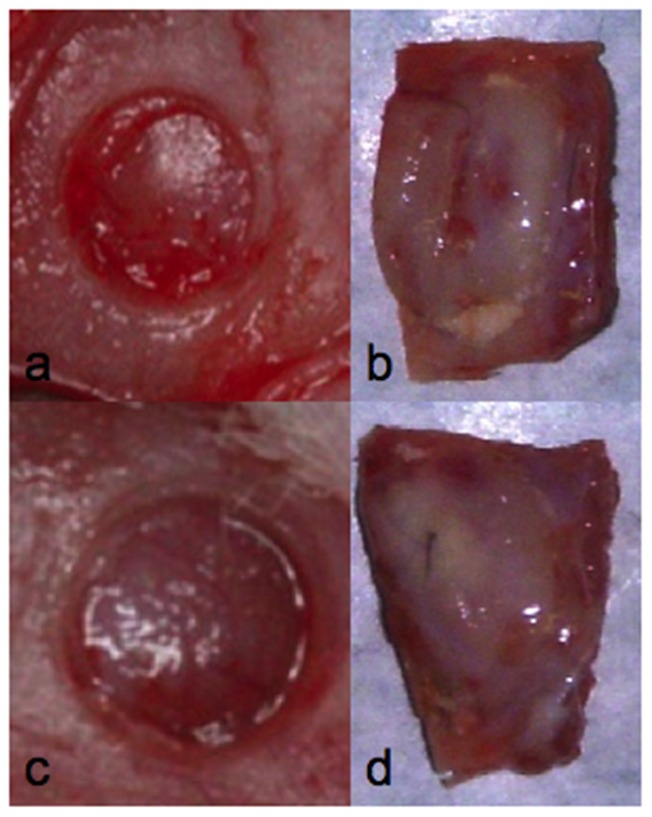
Critical size defect (A, C) before the treatment with DPSCs.Defect after treatment with DPSCs from the younger group (B) and older group (D).